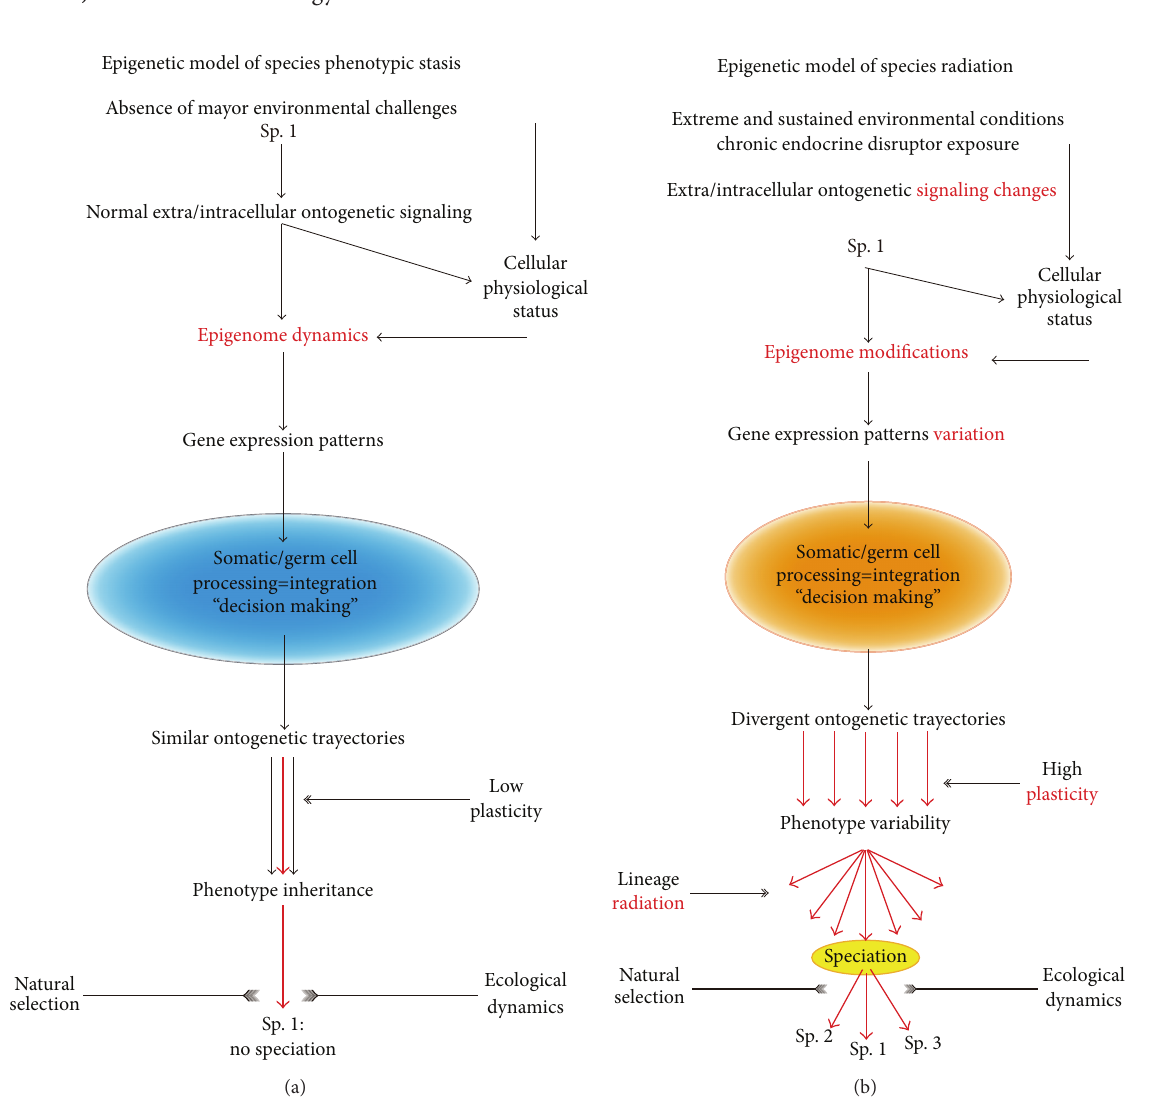
Figure 1: Diagrams that illustrate the hypothetical models by which the phenotype of a given animal species may be preserved under normal environmental conditions (a) or diversified under extreme environmental conditions (b). Phenotypic stasis (a) or speciation (b), respectively, are the end results of these models. Sp.,